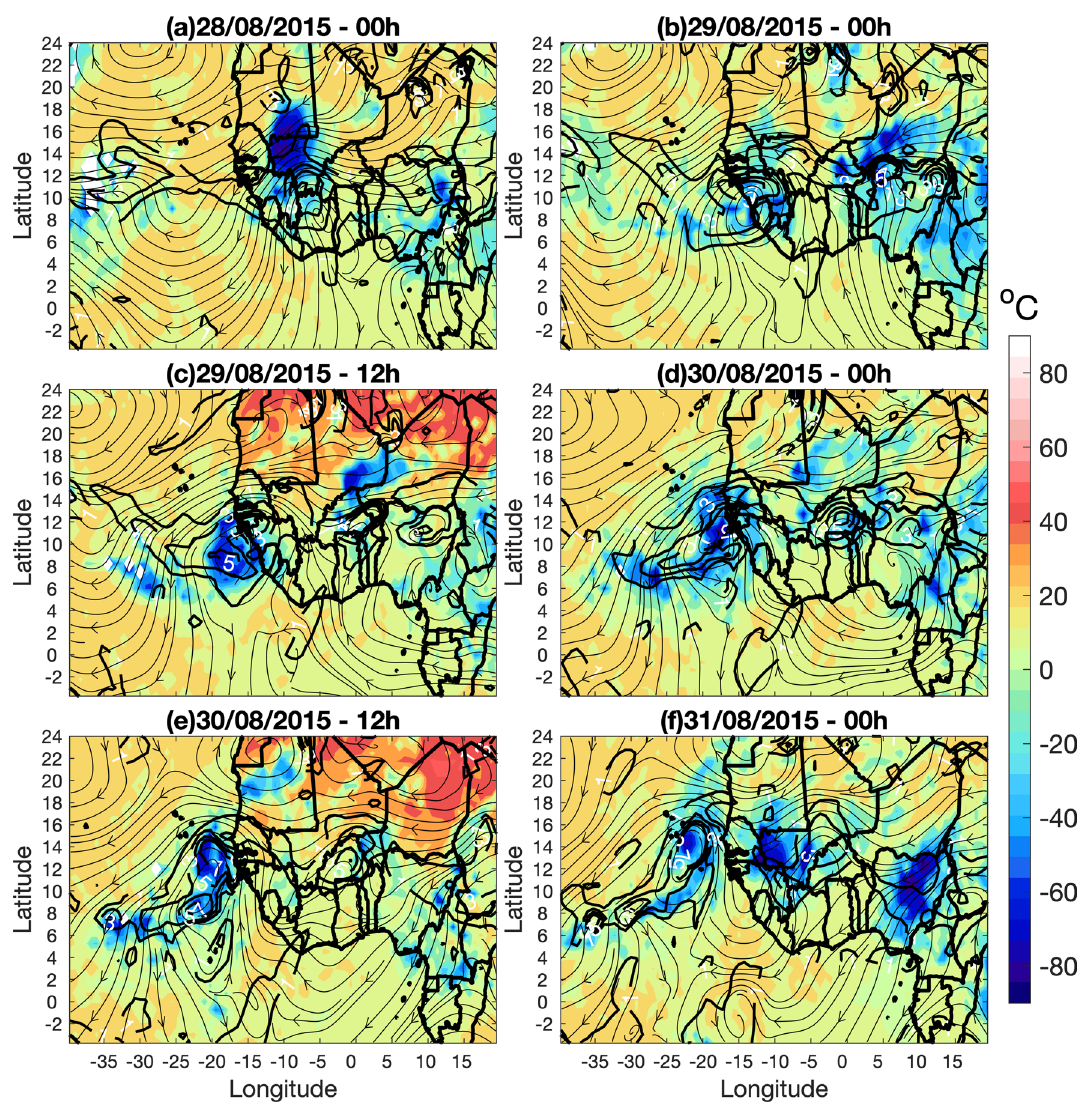
showing the evolution of the disturbance that gave rise to the Hur- ricane Fred off the Senegal-Guinean